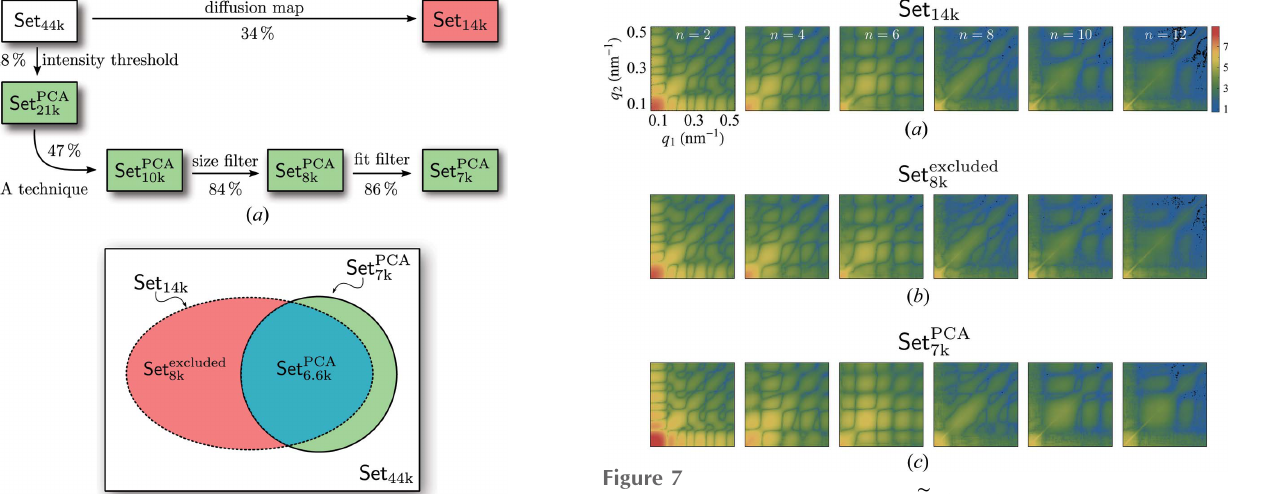
Þj for even order difference ; q 1 2